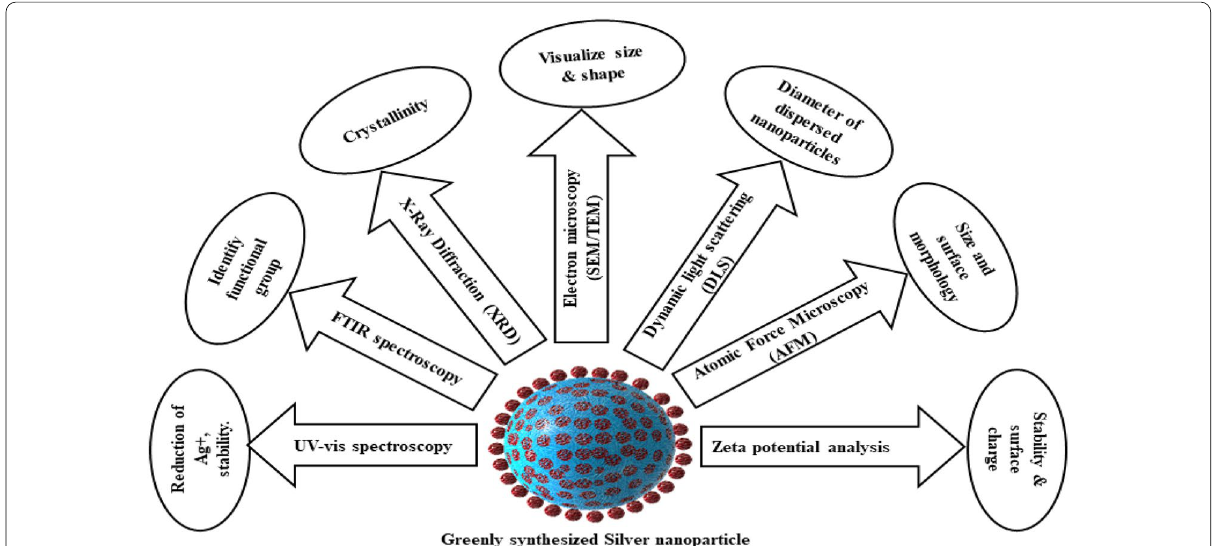
Fig.2 AgNPs with their Characterization